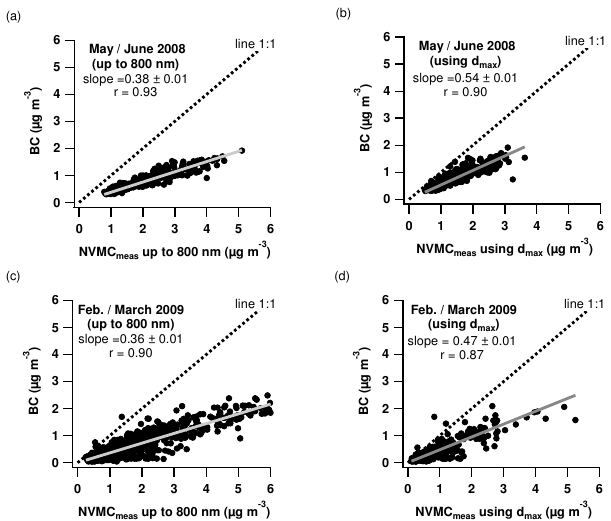
Figure 3. Black carbon (BC) vs. the non-volatile mass concentra- tion (NVMC) estimated from the TDMPS for May–June 2008 and February–March 2009 periods. Estimation of the non-volatile mass concentration was made assuming a density of 1.6gcm − 3 . The left panels correspond to the total V-TDMPS size range (up to 800nm) while the right panels refer to a time-dependent upper size cutting ( d max ). Correlation curves were calculated using the least orthogo- nal distance fit